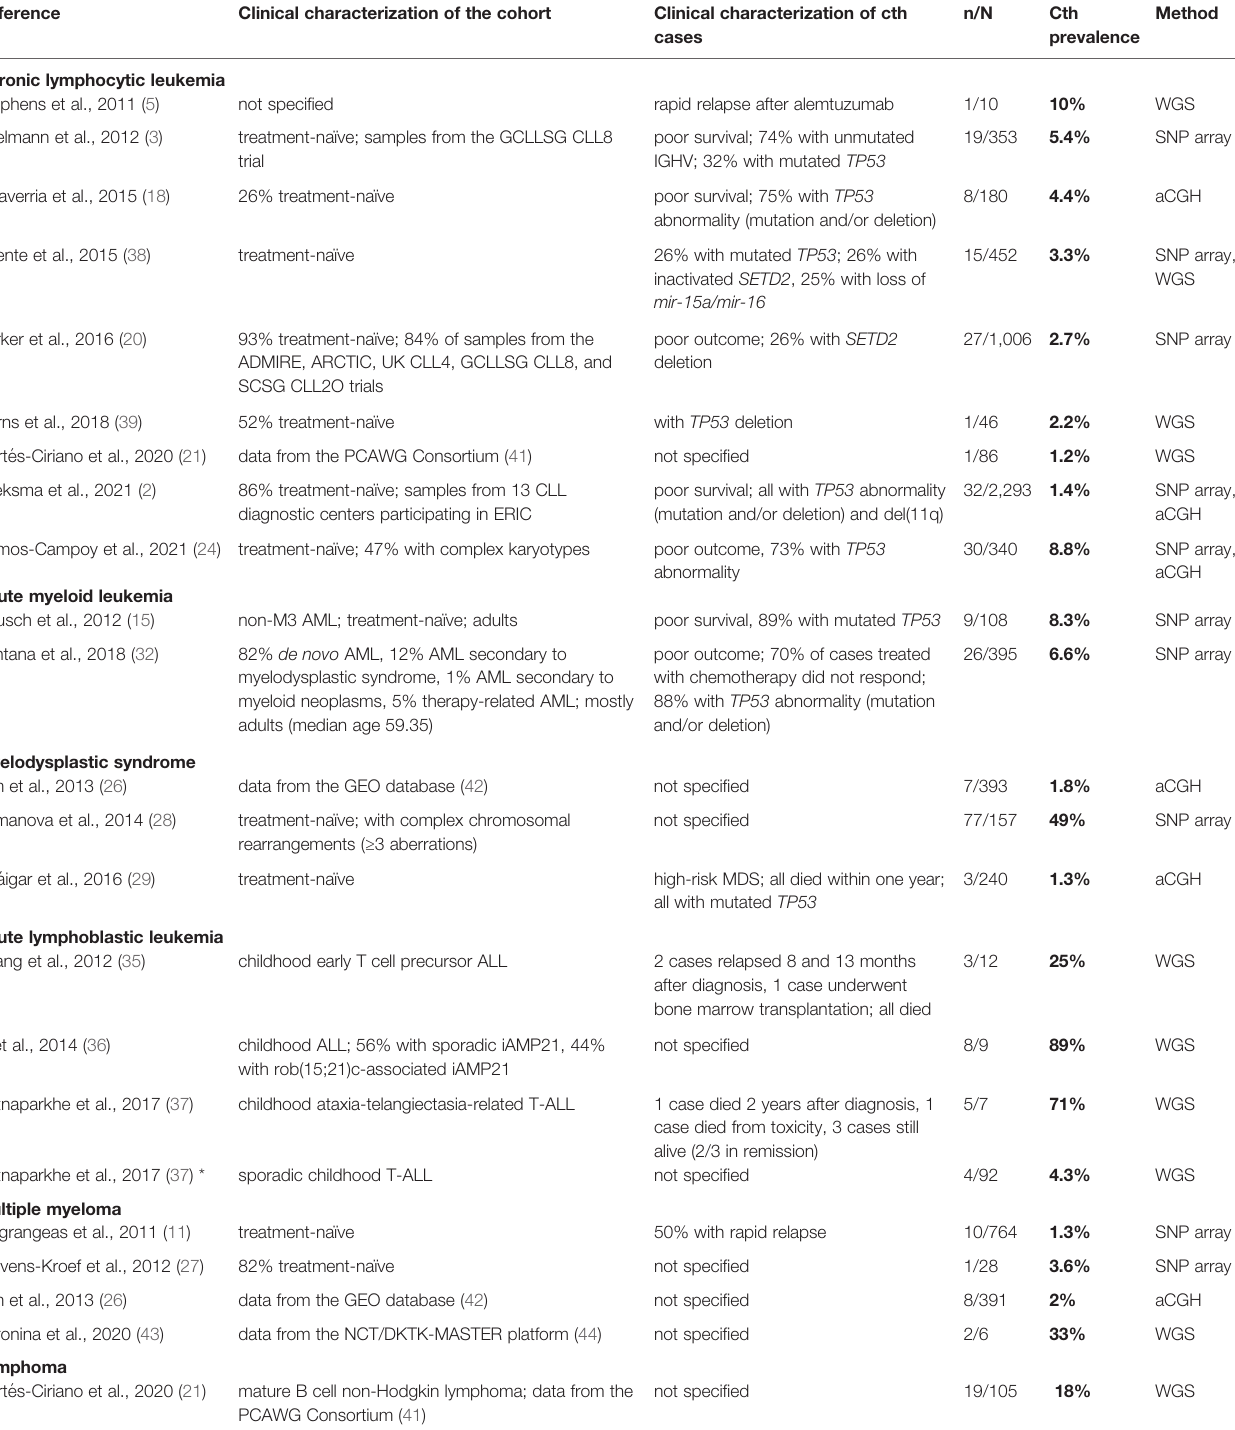
TABLE 1 | Prevalence of chromothripsis in CLL and other hematological